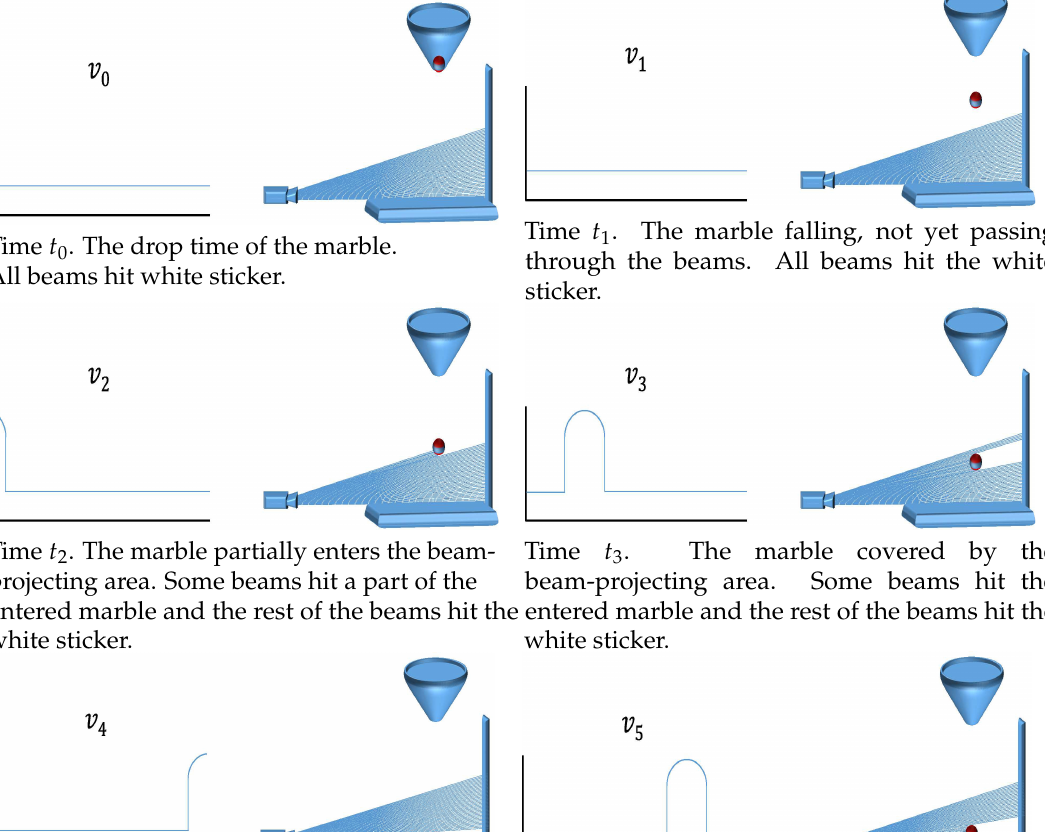
Time t 0 . The drop time of the marble. All beams hit white sticker.